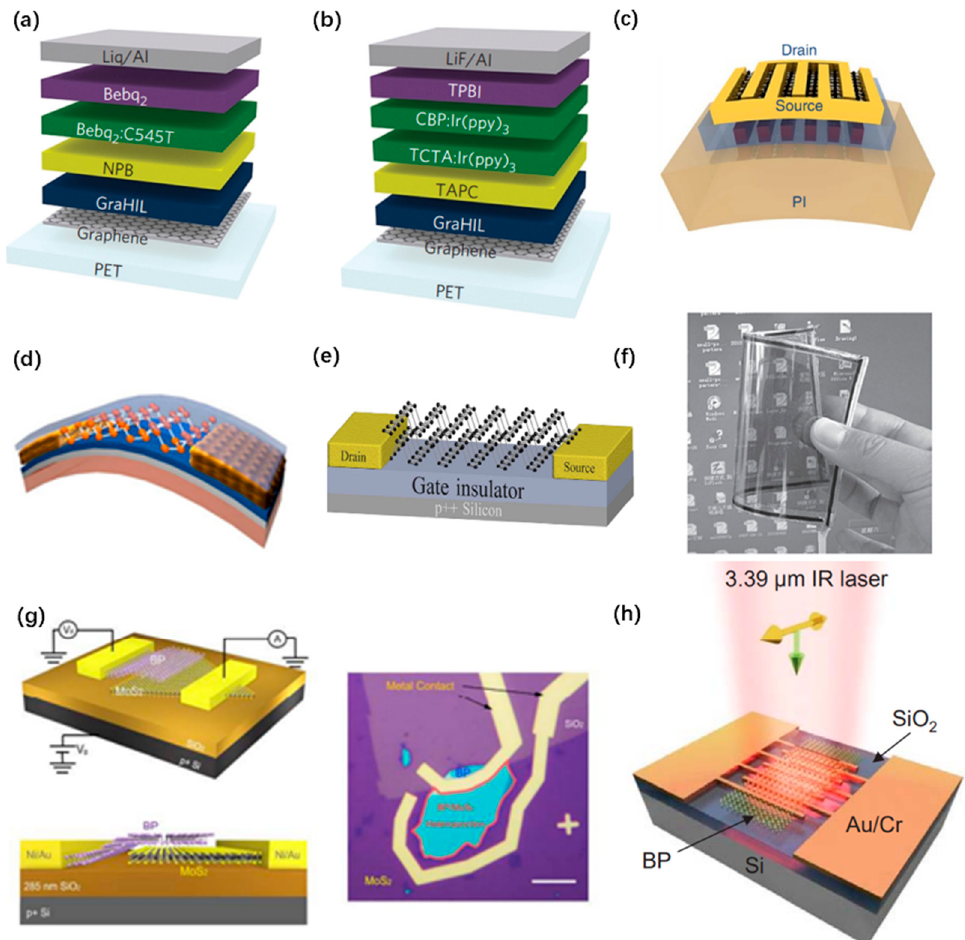
Figure 11. ( a , b ) Device structures of flexible small-molecule fluorescent OLEDs ( a ) and phosphores- cent OLEDs ( b ) using a graphene anode modified with a GraHIL. Reprinted with permission from Ref. [155]. Copyright 2012 Springer Nature. ( c ) Illustration of multifinger embedded-gate graphene device structure that can afford high current drive, thin gate dielectrics, low gate resistance, surface passivation and simple post-transfer fabrication. Reprinted with permission from Ref. [154]. Copy- right 2014 Springer Nature. ( d ) Simplified illustration of the device structure of flexible BG BP FET on PI substrate (not to scale). Reprinted with permission from Ref. [165]. Copyright 2015